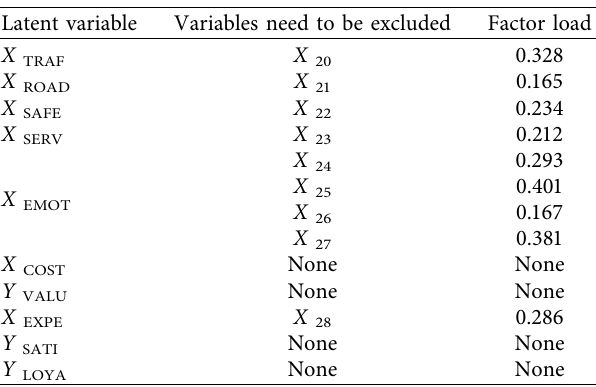
Table 5: Variables that need to be